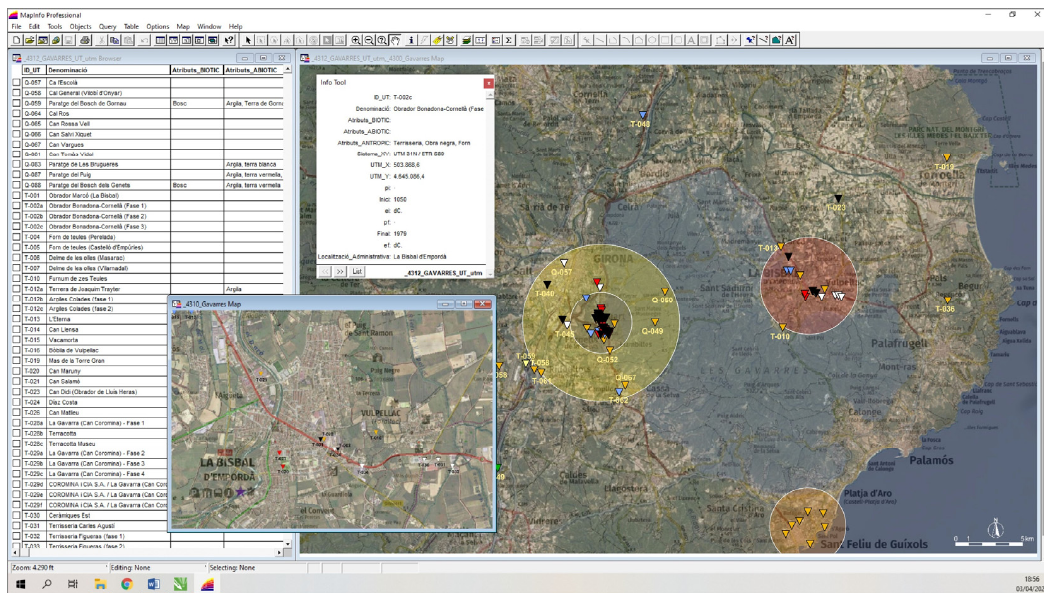
Figure 7. Screen view of GIS-based data exploitation according to the information recorded in the G REYWARE database and exported as a csv-table. The UT table is browsed on the left along with the map view on the right. Units of Topography are represented as dots or polygons, according to the inclusion relation existing between units.